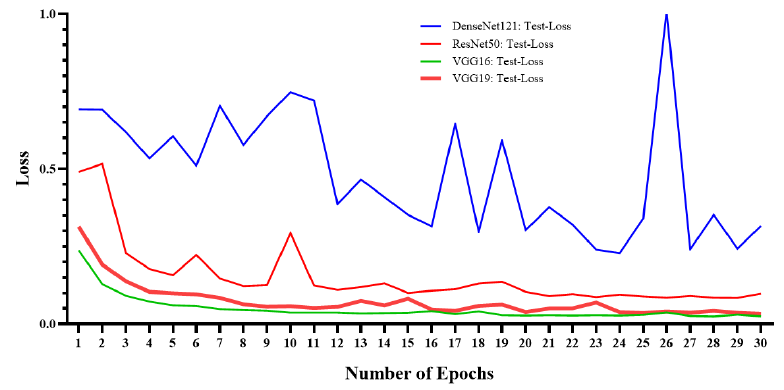
Figure 5. Testing accuracy curve for DenseNet121, ResNet50, VGG16, and VGG19.